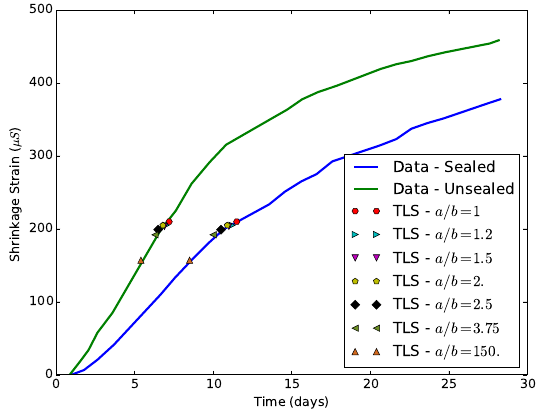
Figure 10. Evolution of the initial shrinkage strains introducing a damage with the different ratios (in blue) and the corresponding trend line (in green).